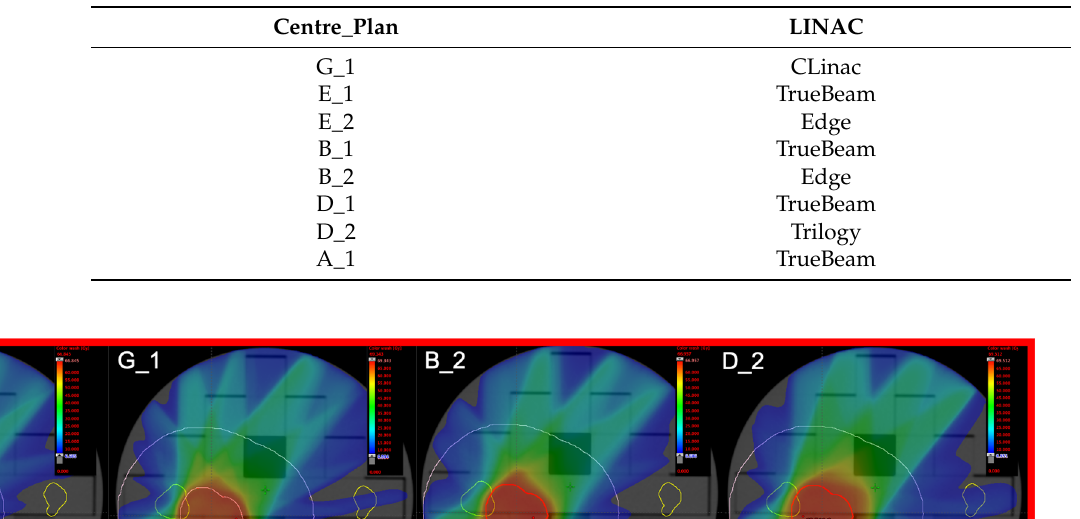
Table 2. List of centres that computed the IMRT dose distribution for the reproducibility and stabil- ity studies.